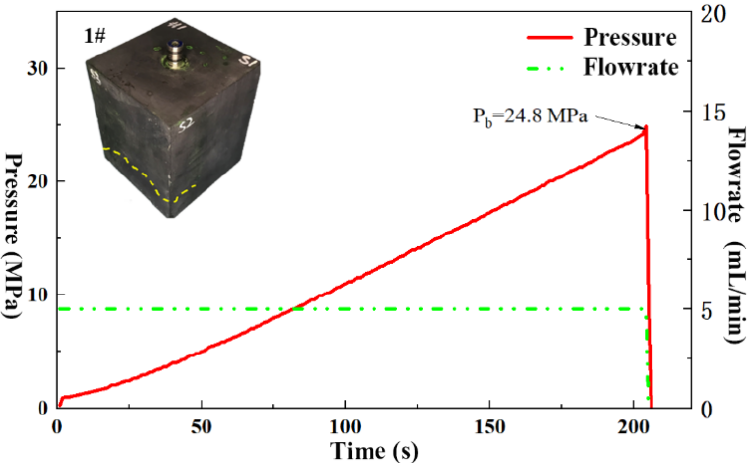
Figure 5. The fracture morphology and pressure curve of specimen 1#.